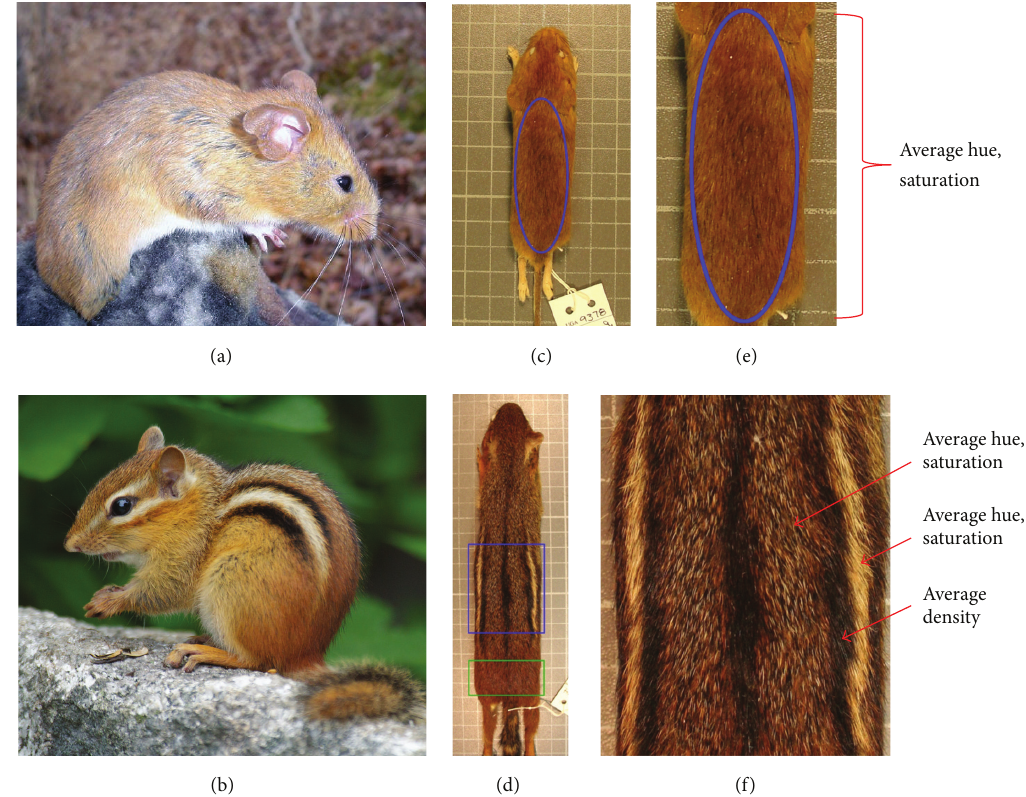
Figure 1: Photographs of the two species studied, golden mouse (a) and chipmunk (b), and method of measuring color from photographs. Specimens were photographed ((c) and (d)), and image analysis software was used to measure fur color in the selected areas ((e) and (f); see Section 2 for color measurement). The agouti, white, and black stripes of chipmunks (f) were measured separately. Rump color (green box in (d)) was also measured in chipmunks. Photo credits: Josh Campbell (a) and Richard Cameron